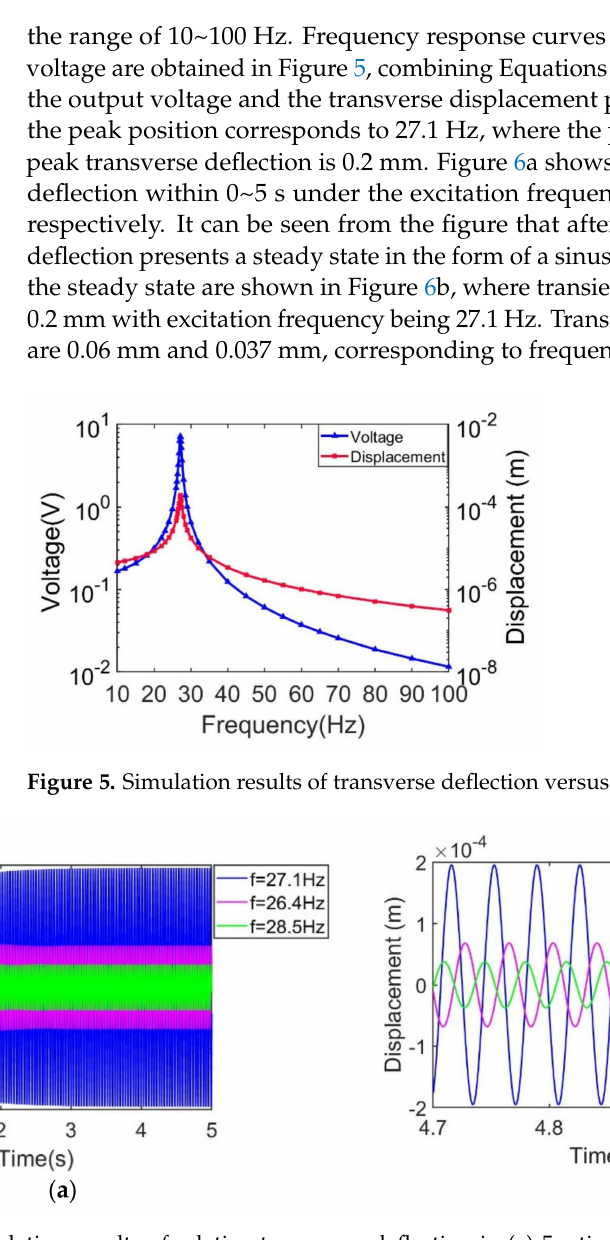
Figure 6. Transient simulation results of relative transverse deflection in ( a ) 5 s time scale and ( b ) 0.3 s time scale at steady